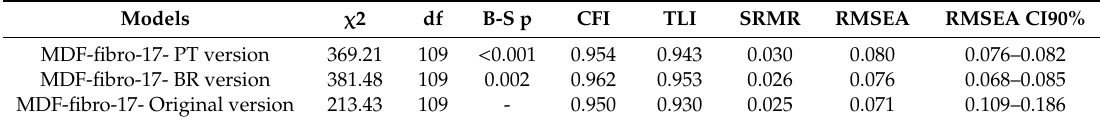
Table 4. Goodness-of-fit indexes of the Portuguese and Brazilian versions and the original model of the Multidimensional Daily Diary of Fatigue-Fibromyalgia-17 (MDF-fibro-17). Models